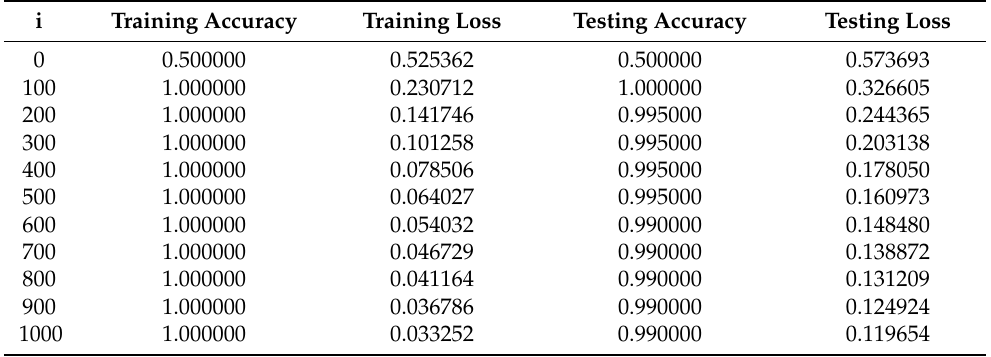
Figure 5. Schematic diagram of R-G in logistic regression. ( a ) Schematic diagram of training dataset. ( b ) Schematic diagram of testing dataset. Table 1. The accuracy and loss rate of training dataset and testing dataset in R-G logistic